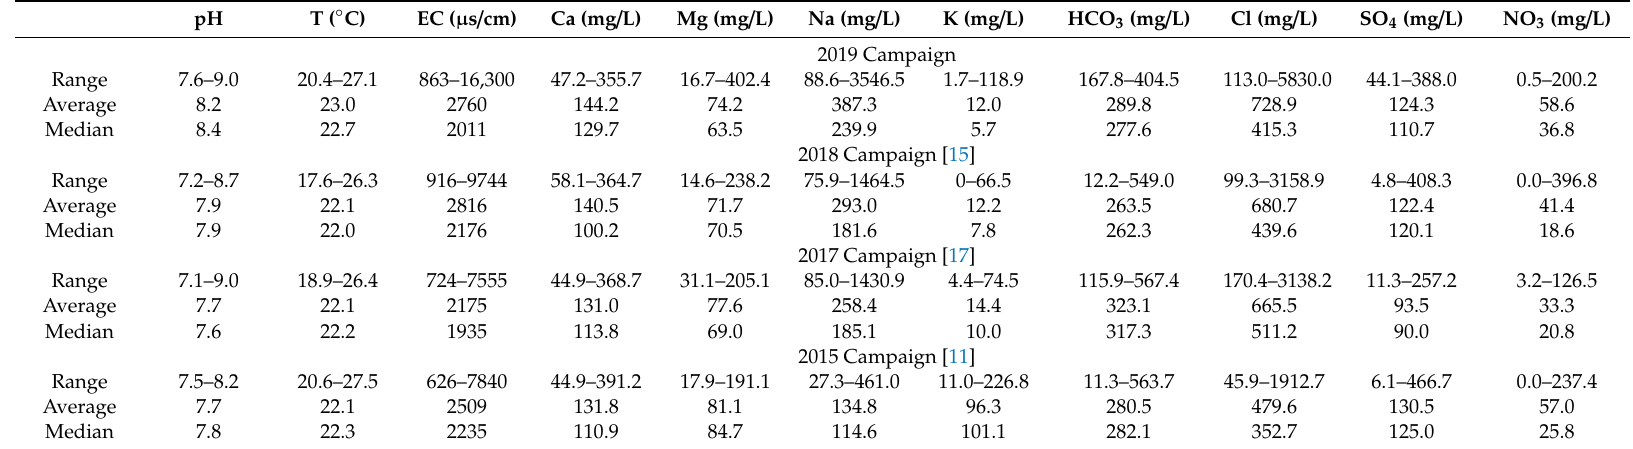
Table 1. Range, average and median of the physicochemical parameters of the analyzed samples from the Plio-Quaternary Aquifer (2015, 2017, 2018 and